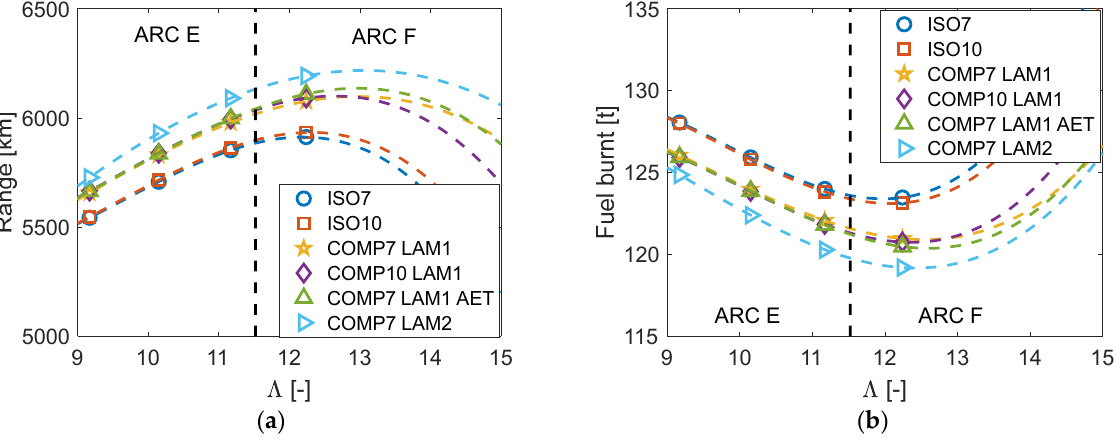
Figure 15. Overall performances of the TALH family in MTOW configuration: ( a ) range; ( b ) fuel burnt on a 10,000 km cruise. Table 9. Fuel burnt (t) on a 10,000 km route, in brackets the variation with respect to Λ = 9.17 with the same section layout.